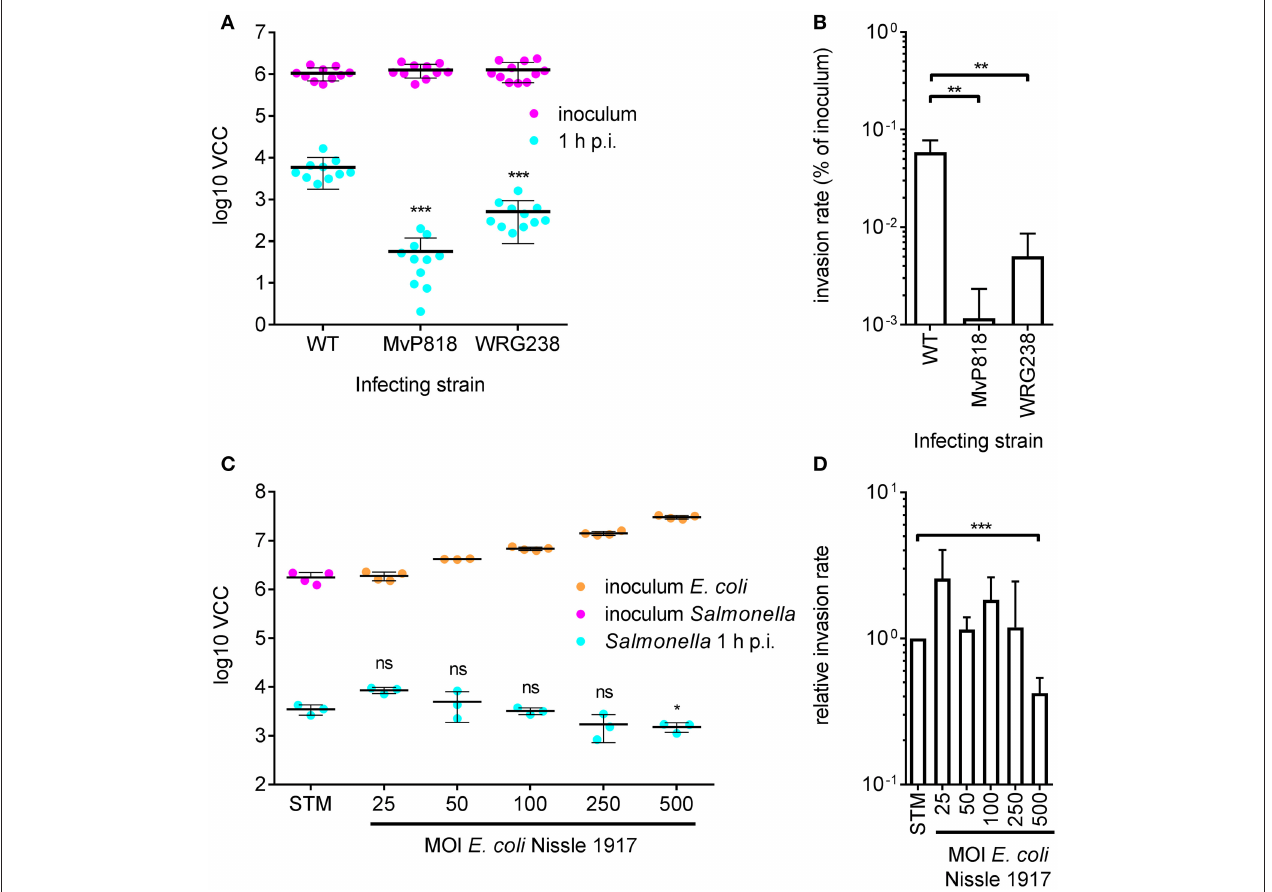
FIGURE 3 | Quantification of invasion of polarized MDCK cells with VCC. (A) Bacterial numbers in the inoculum (magenta) and intracellular bacteria recovered from MDCK infected with the indicated Salmonella strains at an MOI of 25 1h post-infection (p.i.) (cyan) from three independent experiments done in 4-fold replicates are depicted. (B) From the data shown in (A) the invasion rates of the strains were calculated. Both mutants showed a significantly reduced invasiveness compared to the WT. (C) Cells were incubated for 4h before infection using different MOIs of the probiotic E. coli strain Nissle 1917 (Ec Nissle ) as indicated. The amounts of Ec Nissle cells were determined for each MOI using VCC (orange dots). MDCK were subsequently infected with a kanamycin resistant S . Typhimurium WT strain (STM) at an MOI of 25 (magenta) as described in (A) . Intracellular Salmonella (cyan) were significantly reduced when cells were pre-incubated with Ec Nissle at an MOI of 500. Means and standard deviations from one representative out of three similar experiments done in 4-fold replicates (dots) are depicted. (D) The relative invasion rates of STM depending on the MOI of Ec Nissle , normalized to controls without Ec Nissle (STM), were calculated from data of three independent biological replicates. Statistical analysis by Student’s t -test was done by comparing to WT or individual strains as depicted: *** P < 0.001 ** P < 0.01; * P <